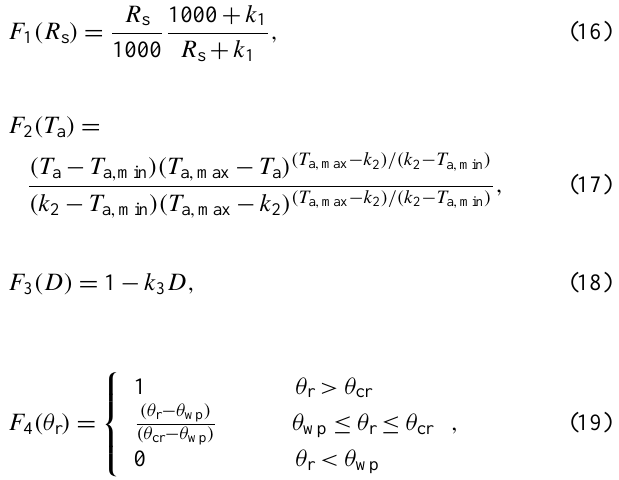
Figure 2. Schematic diagram of the S–W model. From right to left, r c s and r c a are the bulk resistances of canopy stomatal and boundary layer (sm − 1 ) , respectively; r s a and r a a aerodynamic resistances from soil to canopy and from canopy to reference height (sm − 1 ) , re- spectively; r s s soil surface resistance (sm − 1 ) . λT transpiration from canopy (Wm − 2 ) , λE evaporation from soil under plant (Wm − 2 ) , and λ ET total evapotranspiration (Wm − 2 )